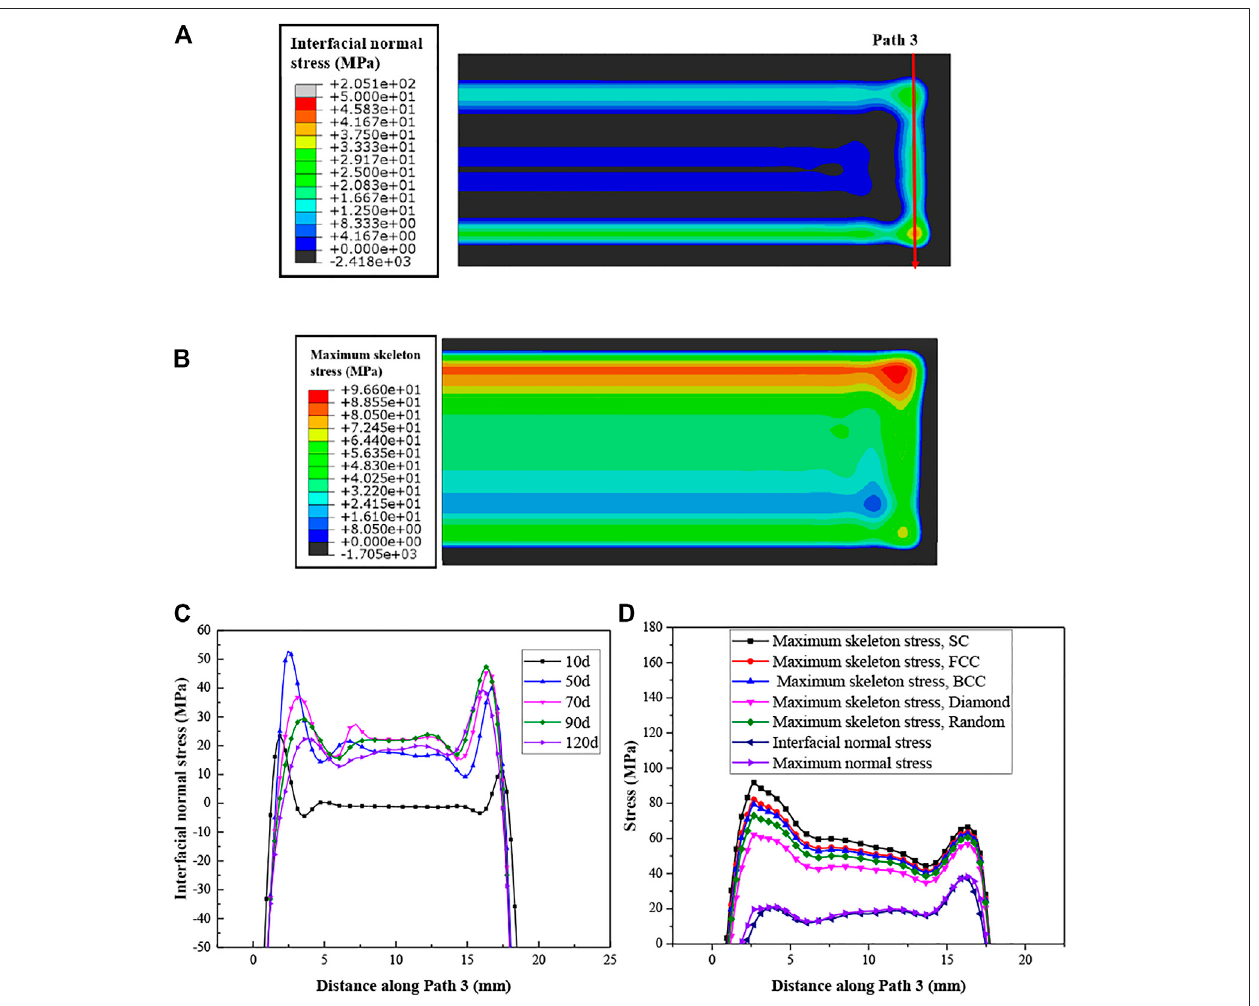
FIGURE 14 | (A) Distribution of the interfacial normal stress between the fuel meat and cladding (the upper side has stronger irradiation); (B) Distribution of the maximum skeleton stress in the fuel meat; (C) evolution of the interfacial normal stress along Path 3; (D) Distribution of the maximum skeleton stress under different bubble distribution patterns along Path 3 on the 120 th